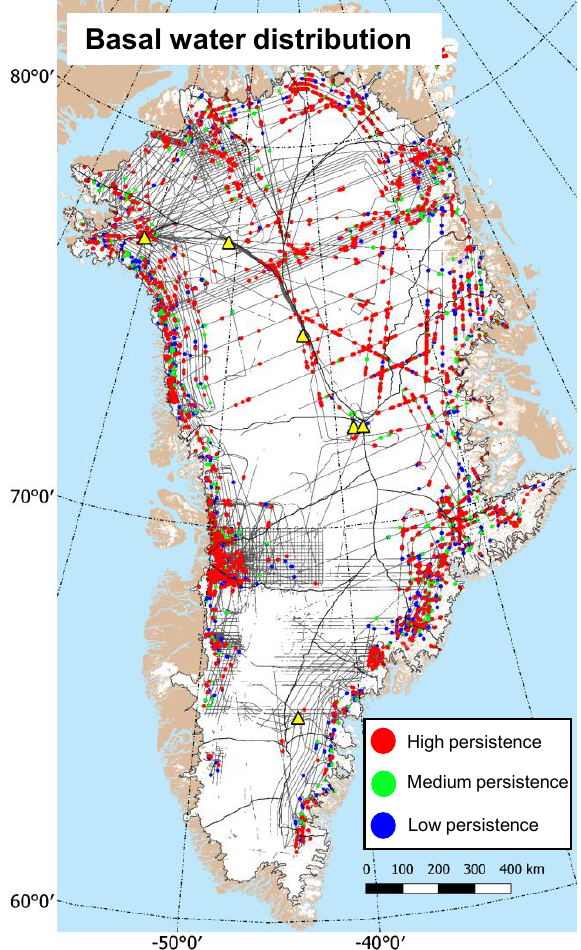
Figure 6. Basal water distribution and robustness to perturbations in the attenuation rate estimate, < N > . The original predictions ( σ [ R ] > 6dB) are represented by all three colours. Persistent water predictions ( σ [ R ] > 6dB for ± 20% and ± 50% perturbations to < N > ) are indicated by the subset of green and red points, and the subset of red points respectively. The subset of red and green points is used in the rest of the